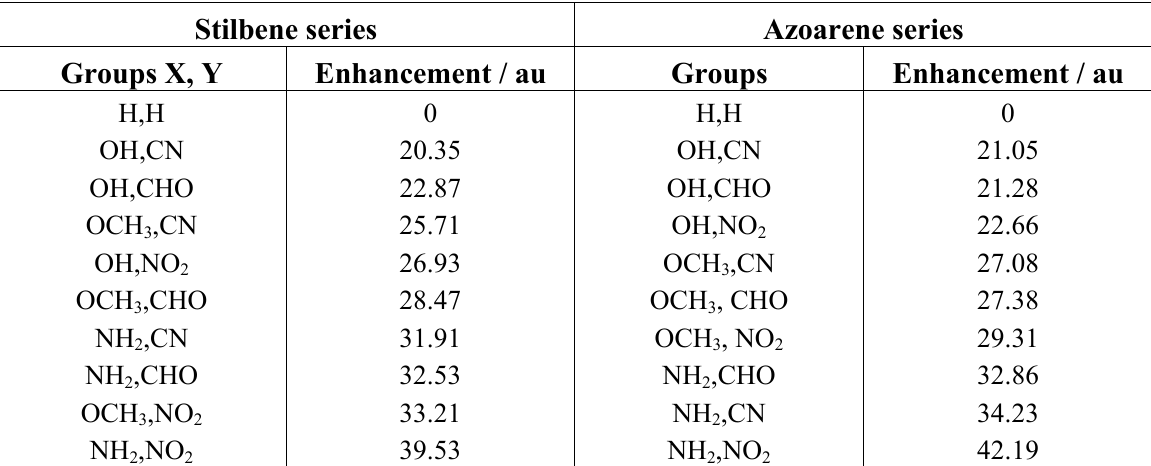
Table 10. Push-pull enhancements to the mean